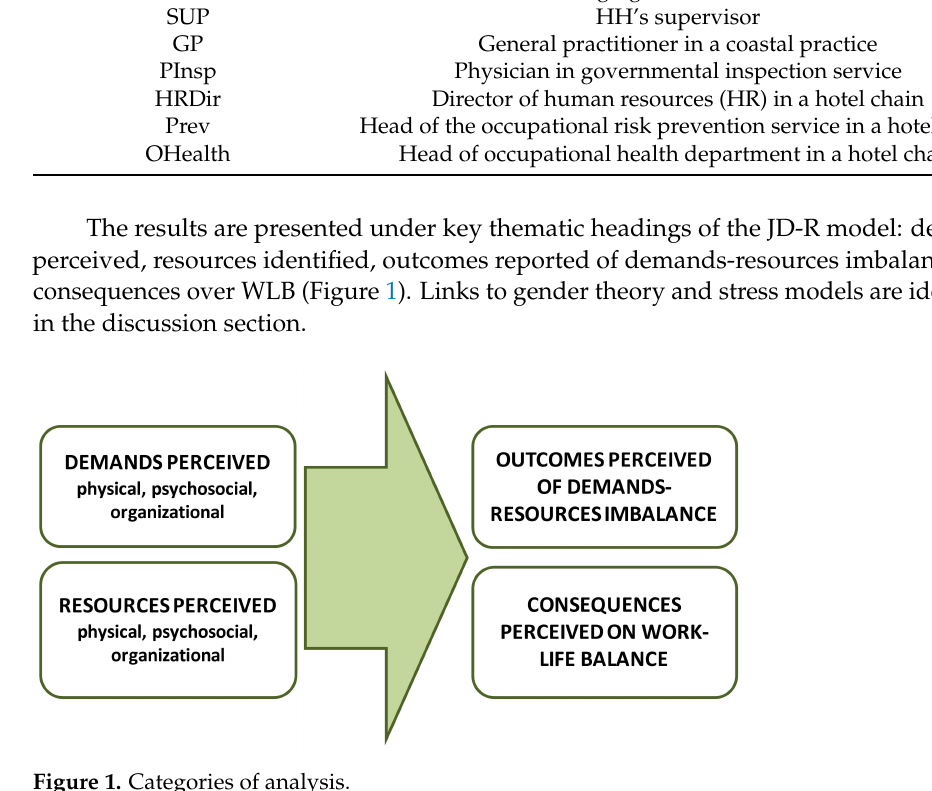
Figure 1. Categories of